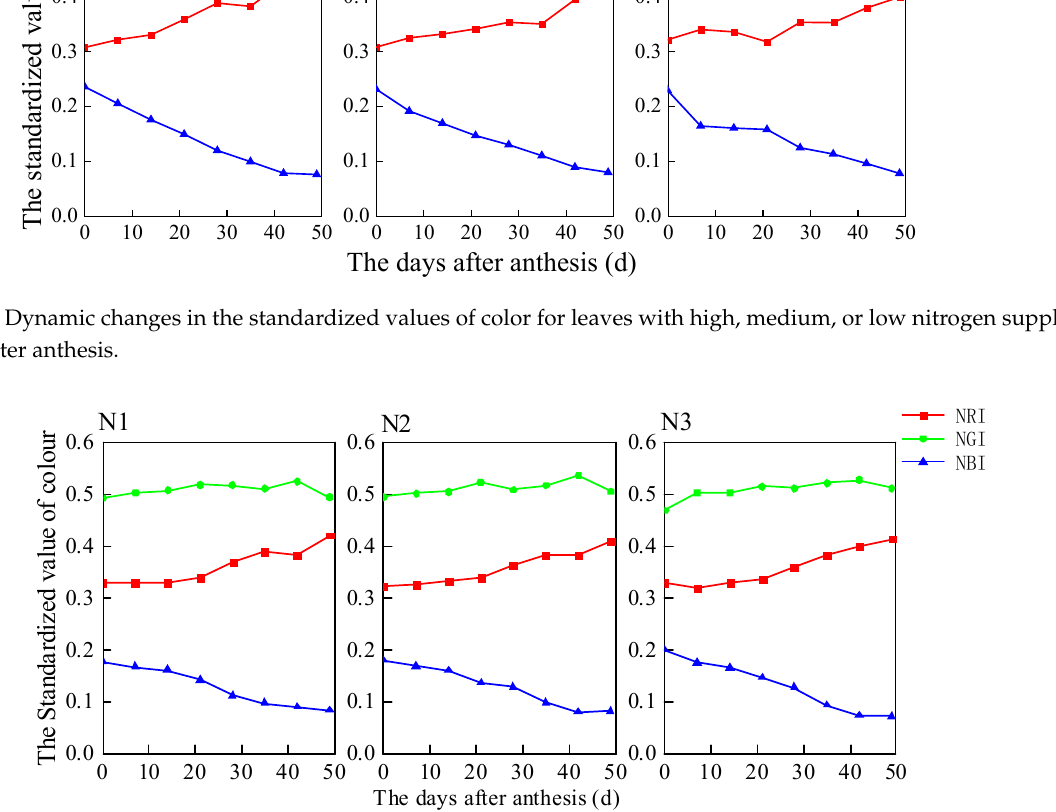
Figure 9. Dynamic changes in the standardized values of color for leaves with high, medium, or low nitrogen supplies in YY8 after anthesis.